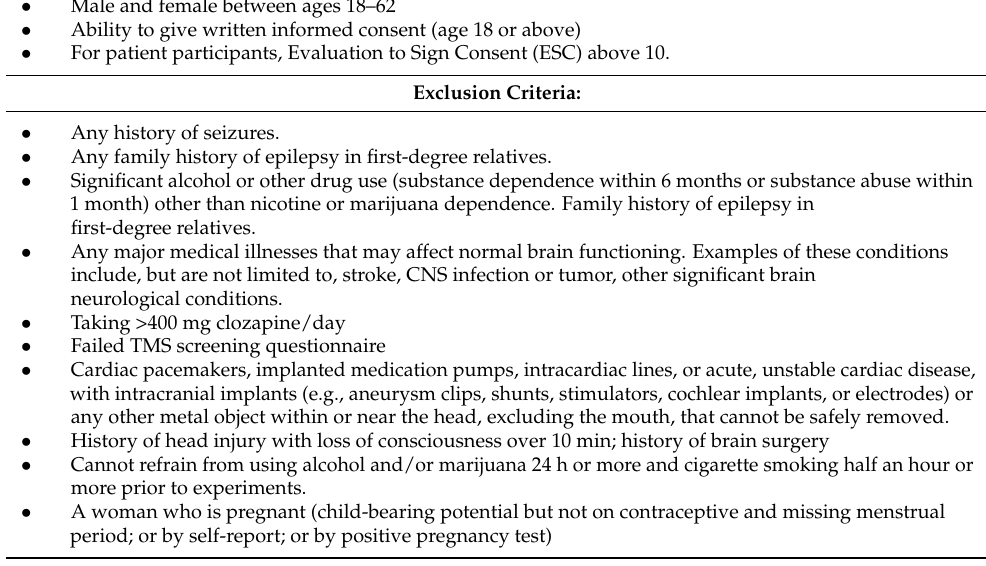
Table 2. Summary of the inclusion and exclusion criteria of the human subjects for our study. Inclusion